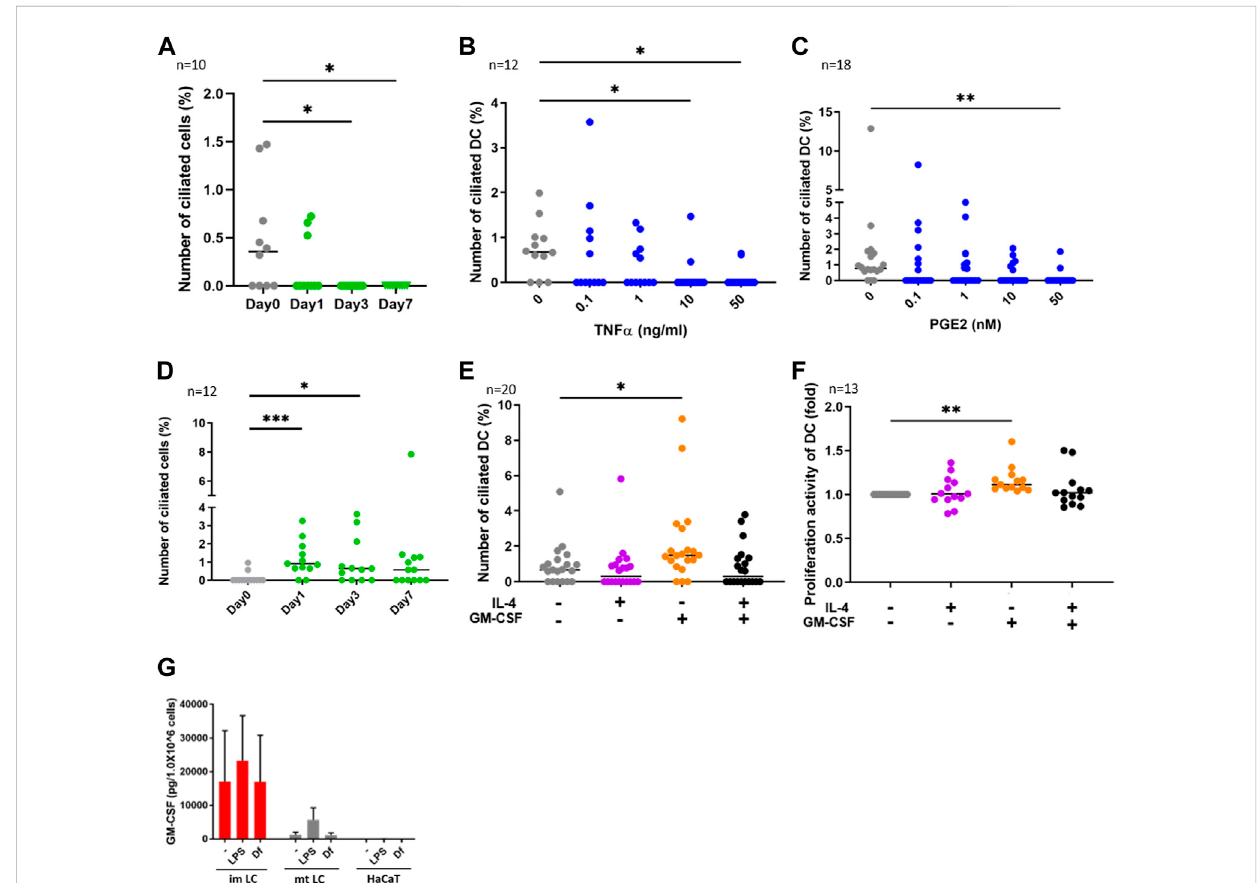
FIGURE 2 cDCmaturationdecreases primary cilium formation. (A) CD14 + monocytes wereisolated fromhumanPBMCs withmagneticbeads, then cells were differentiated into DCs by stimulating with 50 ng/ml GM-CSF, 50 ng/mL IL-4 and 50 ng/mL TNF α . The percentages of primary ciliated cells are shown in thegraph. Thebar indicatesthemedianvalue.*, p < 0.05 (Kruskal-Wallisand Dunn ’ smultiplecomparison).n=10 biologicalreplicates(10donors). (Band C) Human cDCs isolatedfrom PBMCs werestimulated with (B) TNF α or (C) PGE2 for 24 h. The percentages ofciliated cDCs are shown in the graph. Thebarindicatesthemedianvalue.*, p < 0.05,**, p < 0.01(Kruskal-WallisandDunn ’ smultiplecomparison).n=12biologicalreplicates(12donors)andn= 18 biological replicates (18 donors), respectively. (D) CD14 + monocytes were isolated from human PBMCs with magnetic beads, then cells were differentiated into DCs by stimulating with 50 ng/ml GM-CSF and 50 ng/mL IL-4. The percentages of primary ciliated cells are shown in the graph. The bar indicates the median value. *, p < 0.05, ***, p < 0.001. (Kruskal-Wallis and Dunn ’ s multiple comparison). n = 12 biological replicates (12 donors). (E) cDCs isolated from PBMCs were stimulated with 50 ng/mL IL-4 and 50 ng/ml GM-CSF for 24 h. The percentages of primary ciliated cells were counted and graphed. The bar indicates the median value. *, p < 0.05 (Kruskal-Wallis and Dunn ’ s multiple comparison). n = 20 biological replicates (20 donors). (F) Five thousand cDCs isolated from PBMCs were cultured with 50 ng/mL IL-4, 50 ng/ml GM-CSF in RPMI 1640 containing 0.5% FBS and 10%